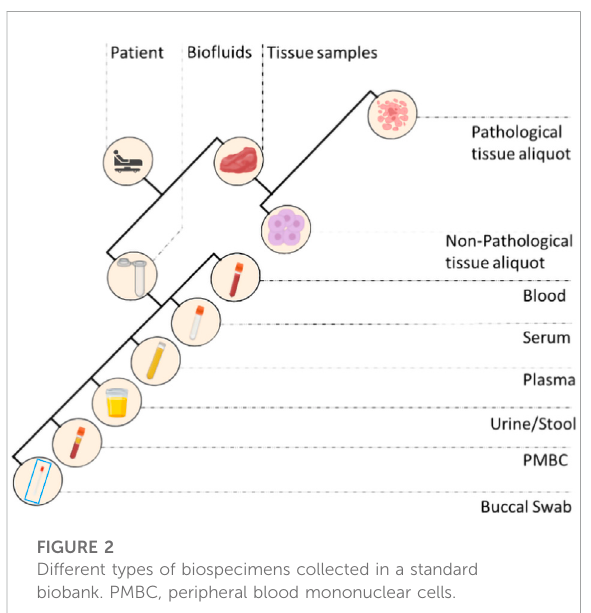
TABLE 1 Examples of non-tissue sample types and corresponding biobank